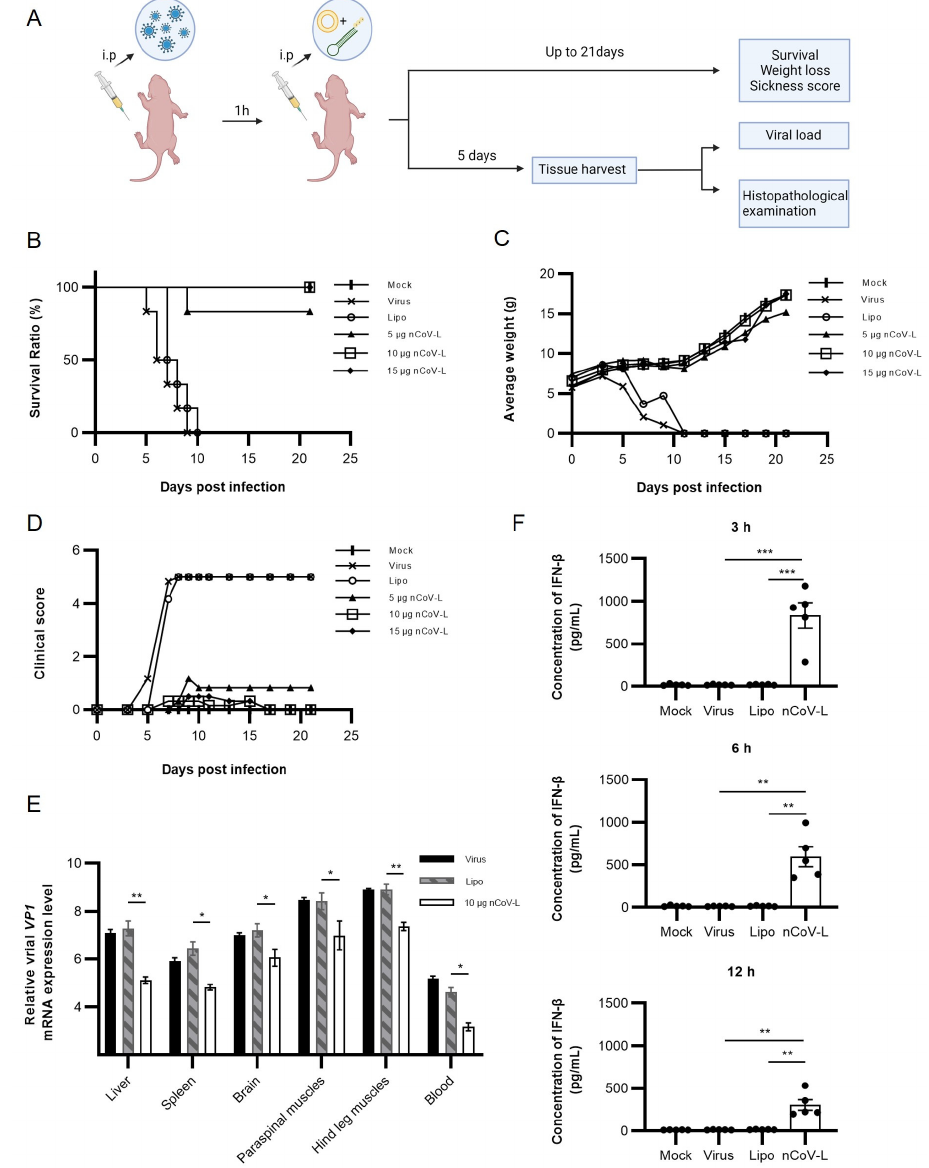
Figure 3. The in vivo antiviral effect of nCoV-L against EV71/C2-2. ( A ) Experimental scheme. 7-day-old BALB/c suckling mice (N = 6) were challenged intraperitoneally with 1.26 × 10 6 TCID 50 EV-71/C2-2. Mice were injected intraperitoneally with PBS, Lipo, 5 µ g, 10 µ g, or 15 µ g nCoV-L complexed with Lipo 1 h later. Survival ( B ), average weight ( C ), and sickness ( D ) were monitored or scored every two days up to 21 DPI. In a separate cohort (N = 3, 10 μ g nCoV-L), blood, liver, spleen, brain tissues, paraspinal, and hind leg muscle were collected for virological and immunological analysis at 5 DPI. ( E ) Viral loads in the above tissues were measured by RT-qPCR. Suckling mice were injected intraperitoneally with PBS, 1.26 × 10 6 TCID 50 EV-71/C2-2, Lipo or 10 μ g nCoV-L complexed with Lipo. Blood was collected 3, 6, 12 h after injection (N = 5). ( F ) Concentration of IFN- β in serum were measured by ELISA. N=5, Bar indicates SD. *, p < 0.05, **, p < 0.01, ***, p < 0.005.